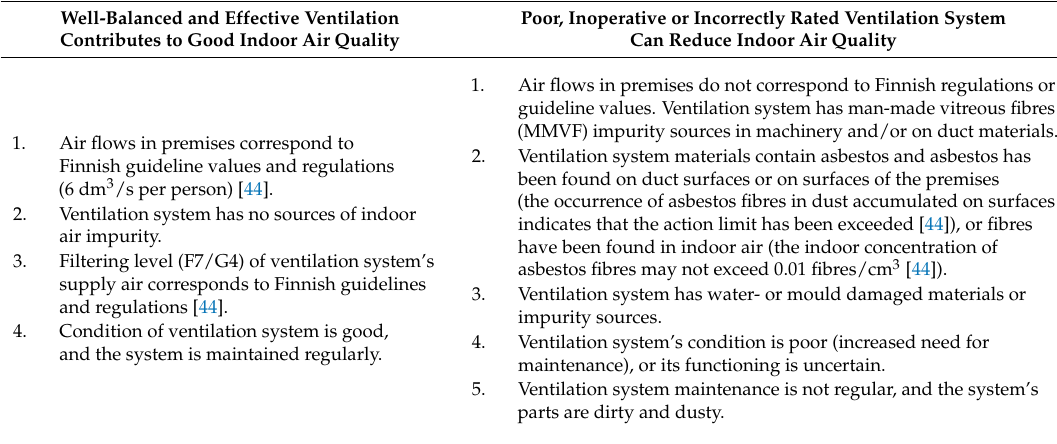
Table 3. Main criteria for assessing impact of ventilation systems on indoor air quality (IAQ). The category “Well-balanced and effective ventilation contributes to good indoor air quality” is achieved only if all options are selected.